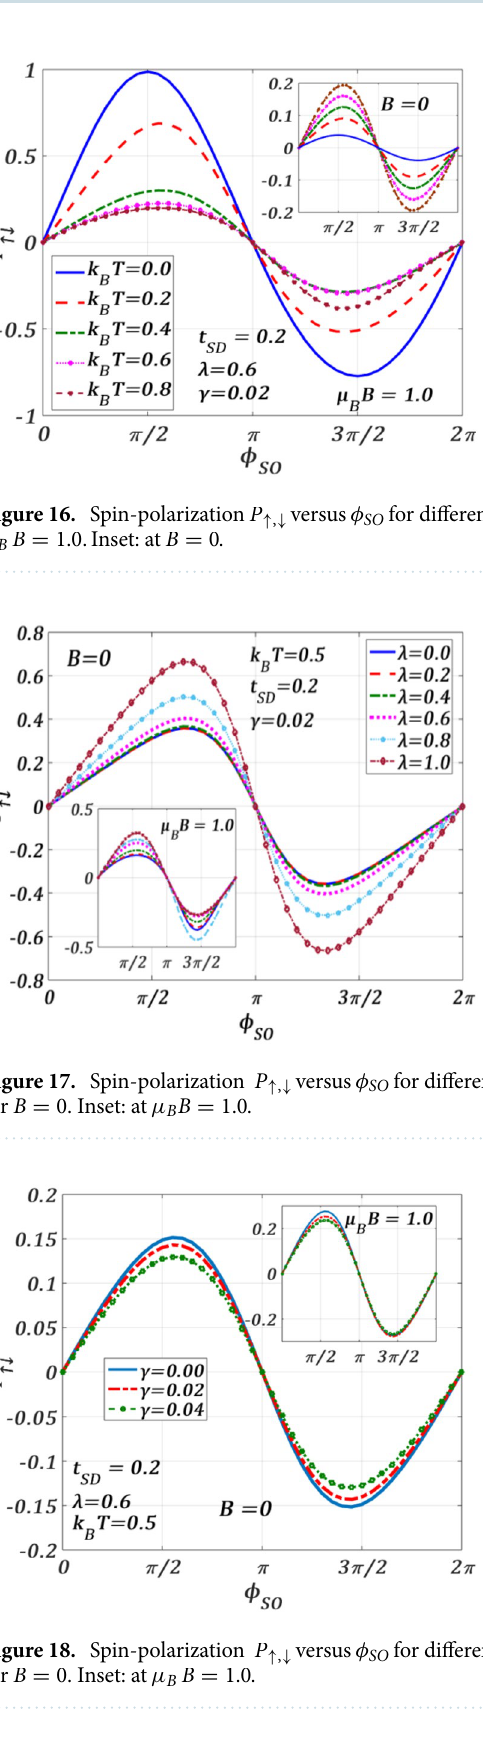
Figure 18. Spin-polarization P 0 . Inset: at µ B B for B =